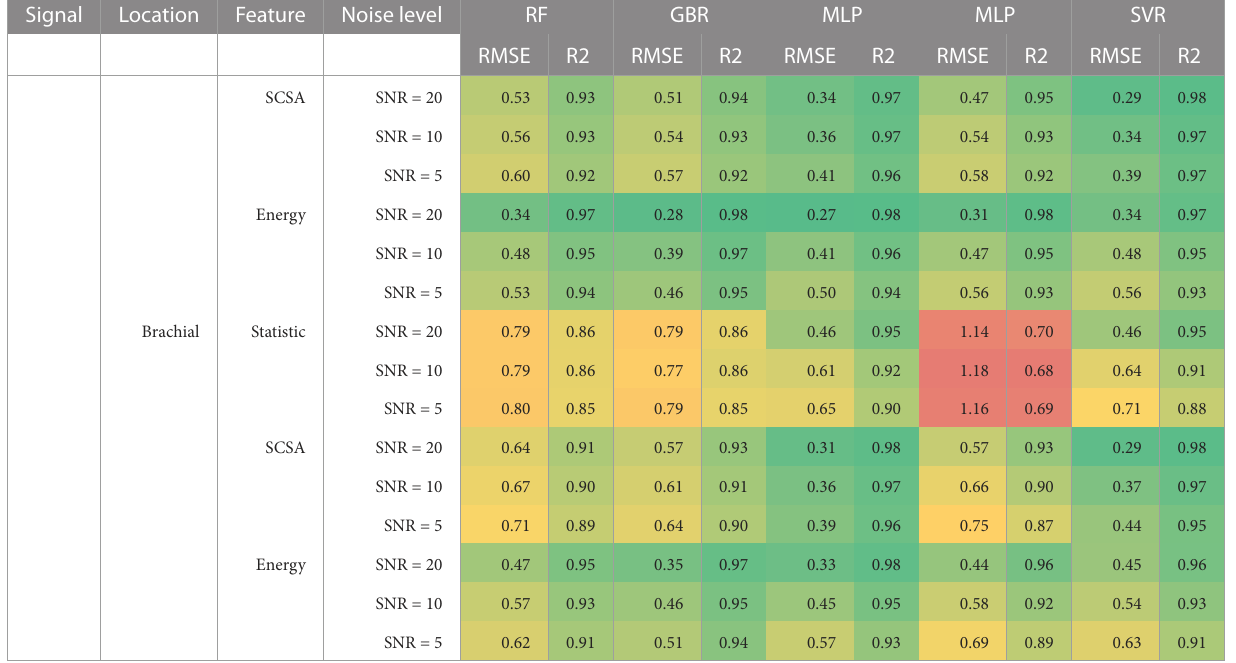
the SVR model, and values of R 2 = 0 . 92 and RMSE = 0 . 60 for the SNR = 30 using the MLP and SVR models. In contrast, the worst results were obtained in all the cases by the MLP models using statistic features with values of R 2 = 0 . 76 and RMSE = 1 . 01 for the Radial location with SNR = 0 . 65, R 2 = 0 . 68 and RMSE = 1 . 17 for Digital and brachial location with SNR = 0 . 45, and R 2 = 0 . 65 and RMSE = 1 . 23 for Digital and brachial location with SNR = 0 . 30. For the BP spectrogram, The best values obtained were applied for Radial locations with values of R 2 = 0 . 98 and RMSE = 0 . 26 for the SNR = 20 using the GBR model with the energy features, R 2 = 0 . 98 and RMSE = 0 . 32 for the SNR = 10 using the SVR model with the SCSAfeatures,and R 2 = 0 . 97and RMSE = 0 . 38forthe SNR = 5using the SVR model with the SCSA features. In contrast, similar to the PPG spectrograms, the lower results were obtained for the MLR models using the statistical features obtaining values of R 2 = 0 . 70 and RMSE = 1 . 14 for SNR = 20, R 2 = 0 . 68 and RMSE = 1 . 18